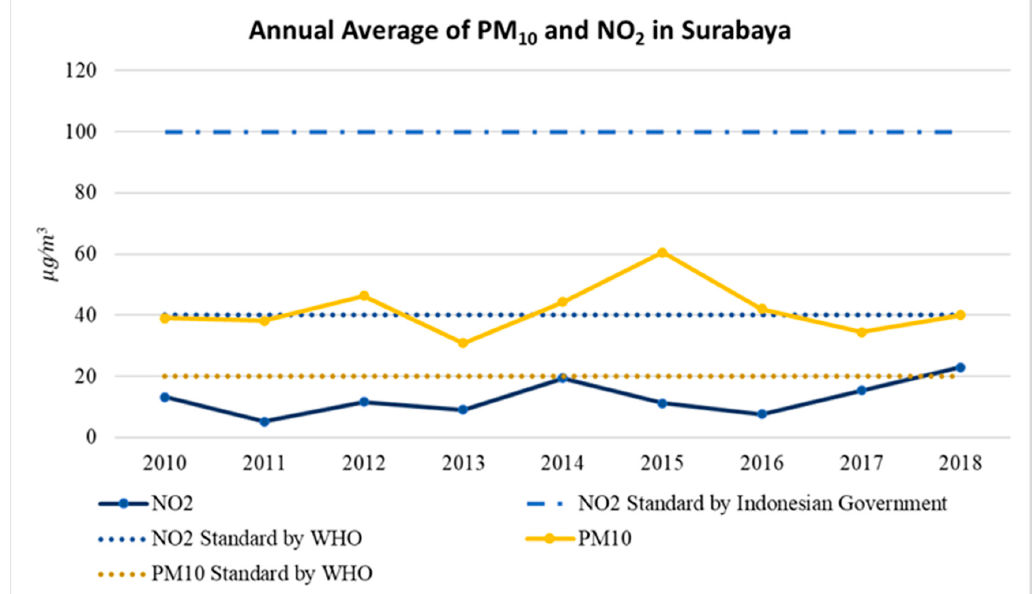
Figure 2. Time-series trend of air pollutants (particulate matter (PM 10 ) and nitrogen dioxide (NO 2 ) concentrations) in Surabaya from 2010 to 2018.